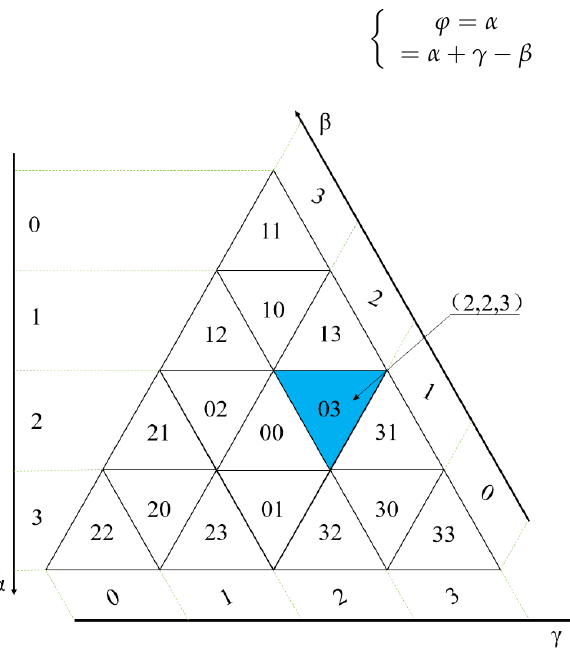
Figure 16. The three-orientation coordinate system of the triangular grids.